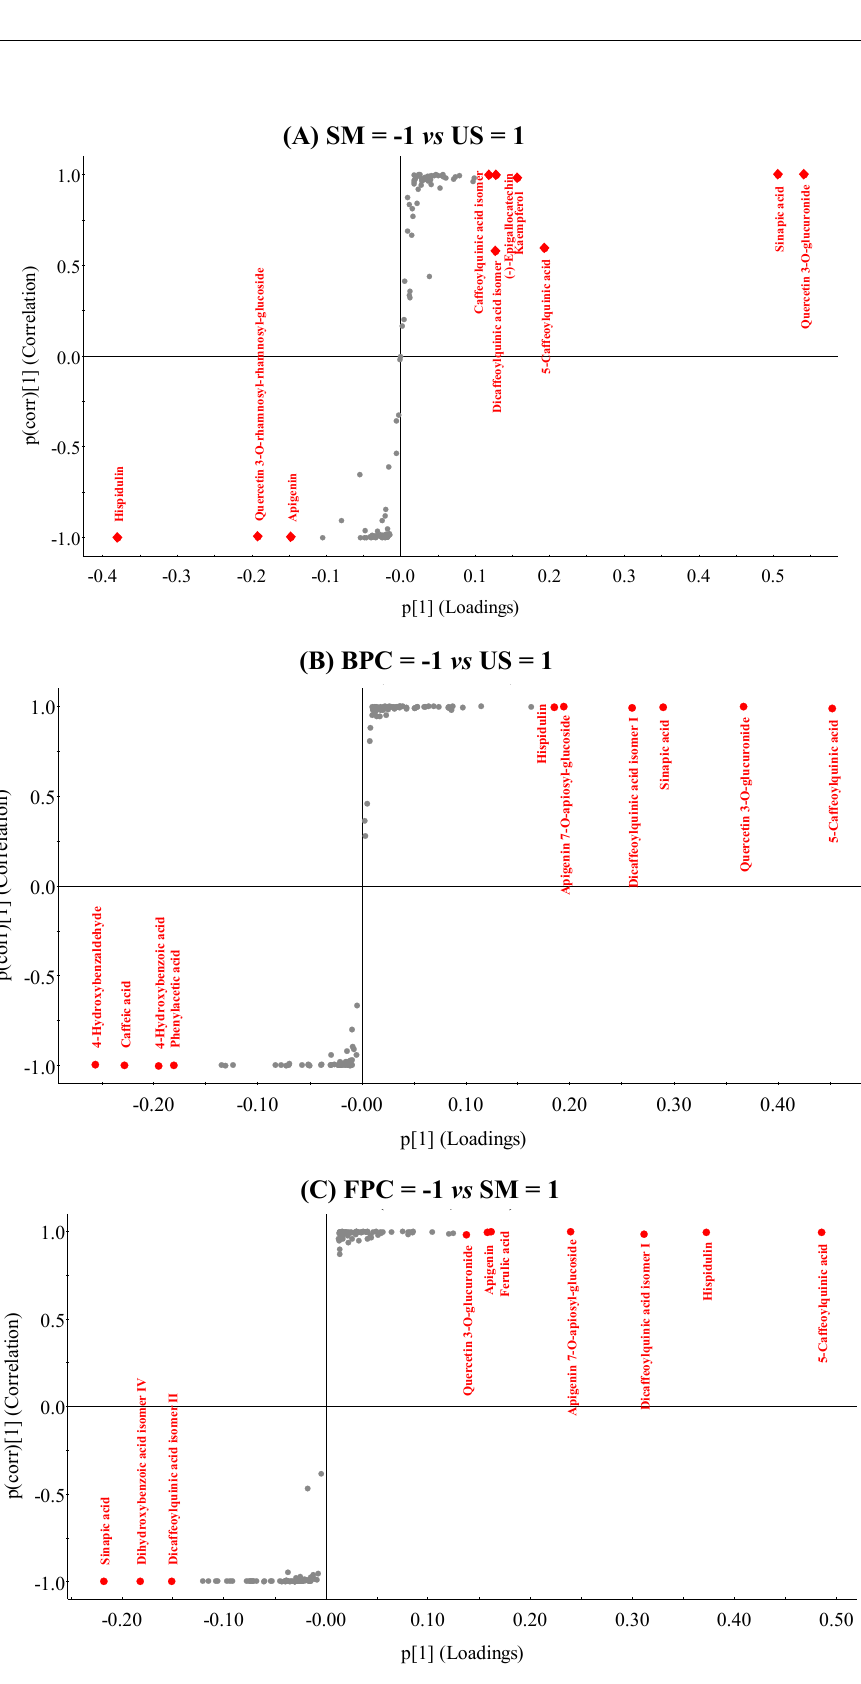
Figure 5. Comparative analysis between extracts: s-plot of orthogonal partial least squares discriminant analysis (OPLS-DA) of ( A ) ultrasonication (US) vs. total phenolic content (TPC) extracts, ( B ) selected mixture (SM) vs. US extracts, and ( C ) TPC vs. SM extracts.